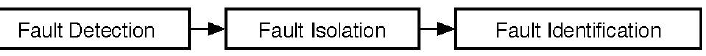
Figure 1. Fault diagnosis